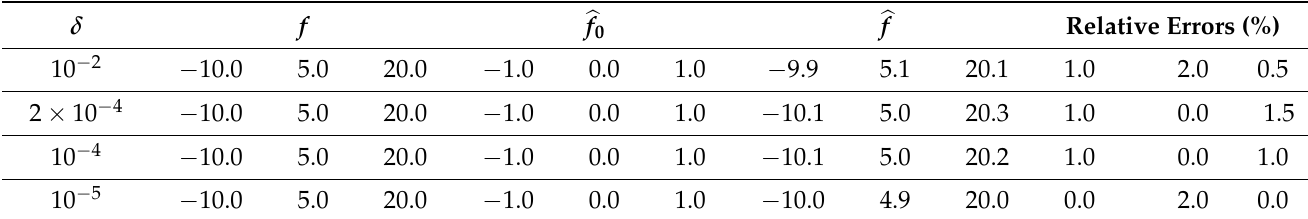
Table 2. Identification results of the observation drift elements f .